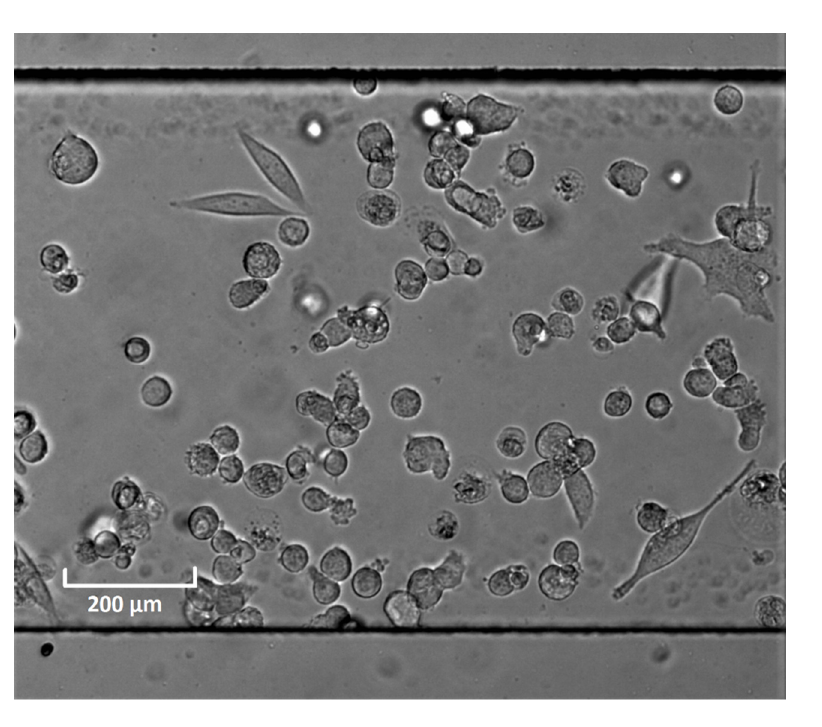
Figure A1. Example image of PC-3 cells cultured inside the microfluidic channel.